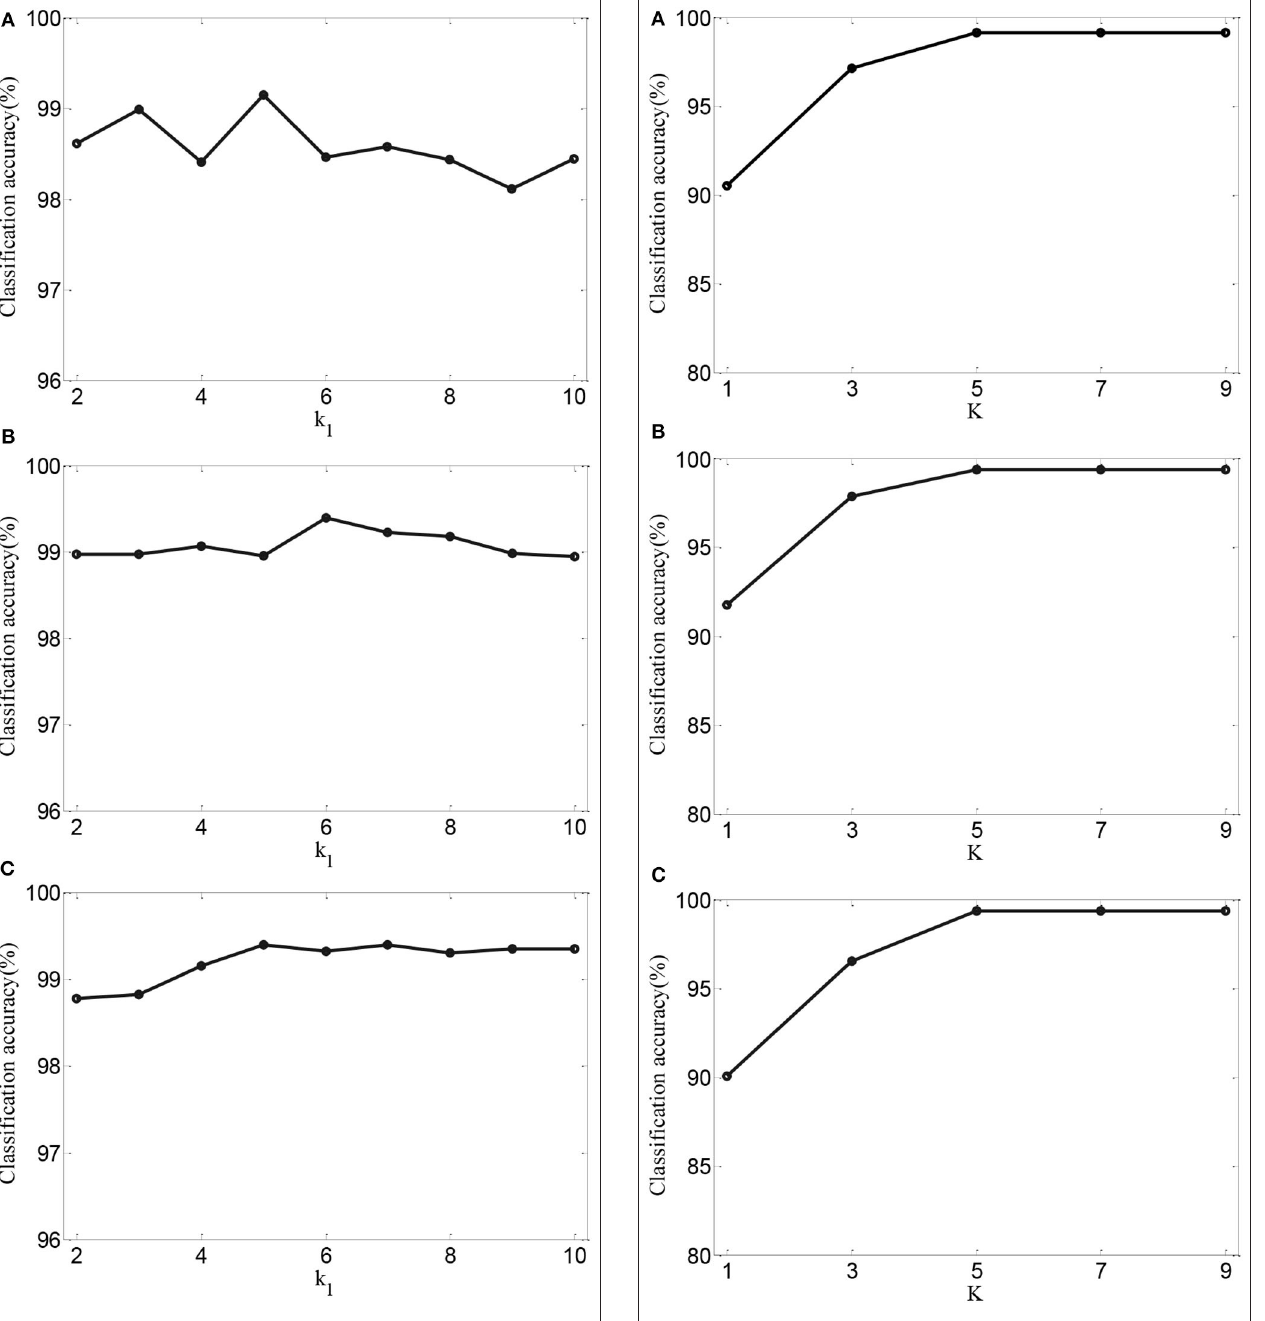
FIGURE 5 | Classification accuracy of AMDML-KNN with different values of K for (A) Task 1, (B) Task 4, and (C) Task